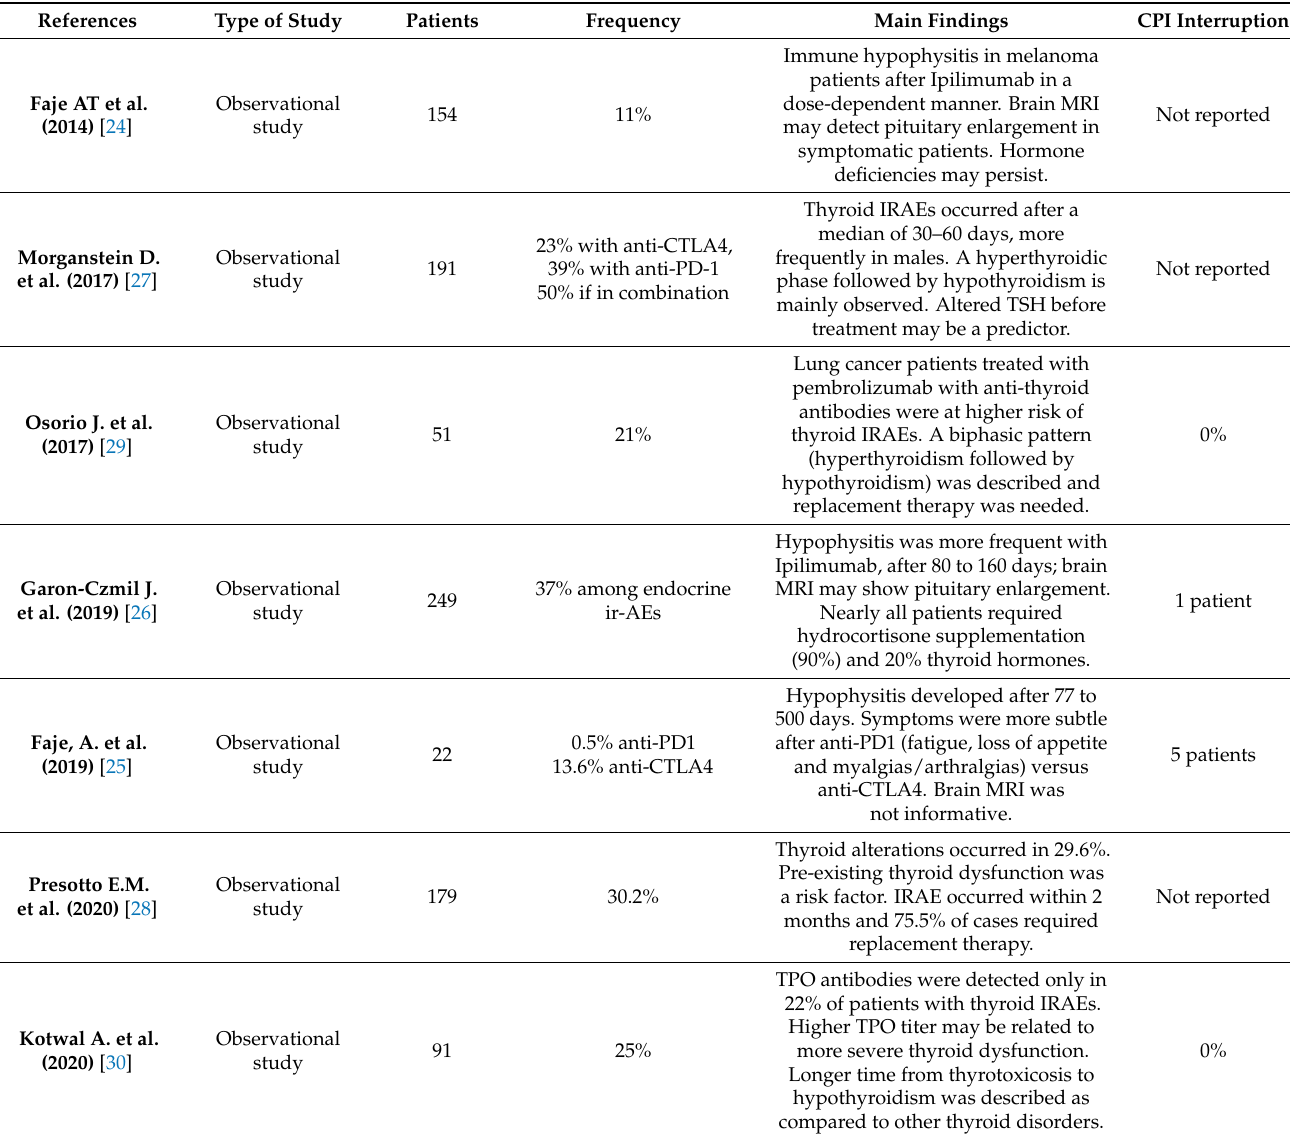
Table 2. Immune-related endocrinopathies after checkpoint inhibitors